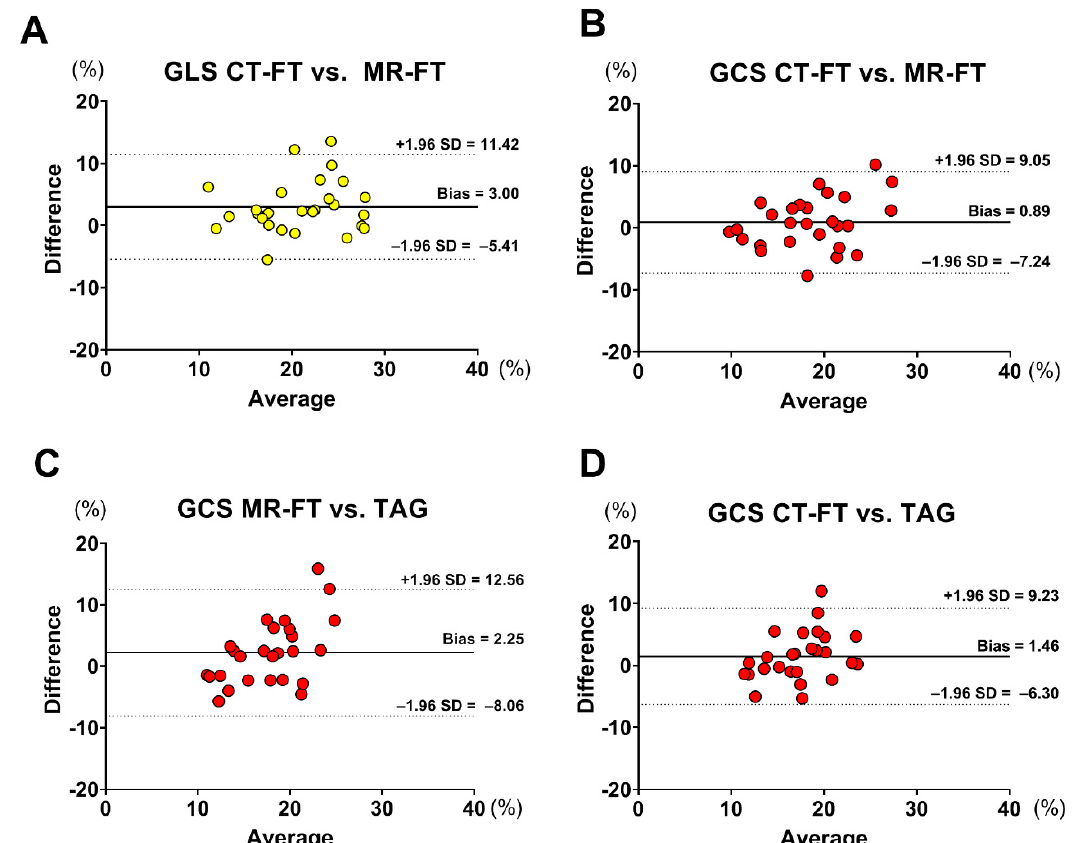
Figure 4. Assessment of GCS in the same subject from the mid-ventricular short-axis (SAX) view using CMR-FT ( left ), CT-FT ( middle ), and TAG ( right ).